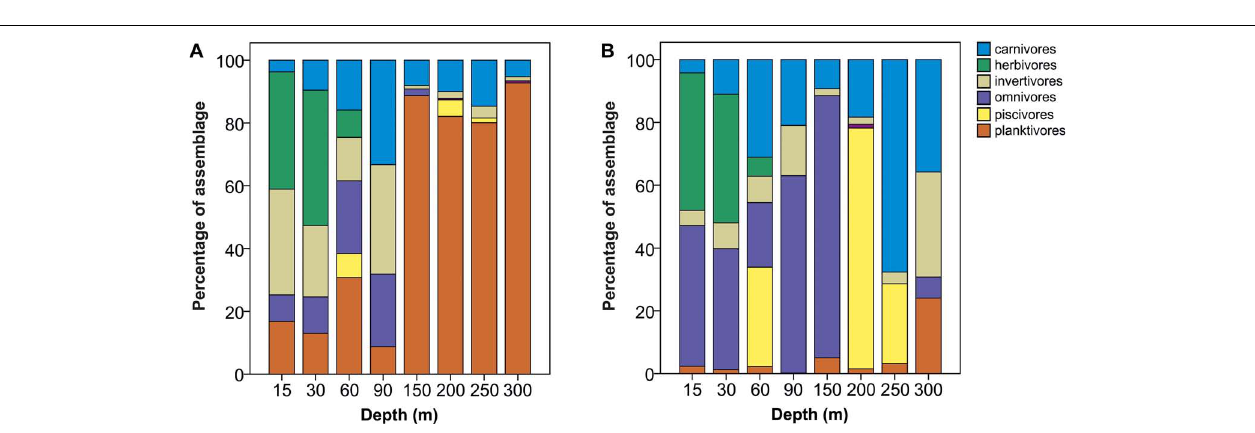
FIGURE 4 | Rank orders based on average species abundances on Plantagenet Bank and the sites from the Bermuda slope (North Northeast, Spittal, and Tiger). Lines connect the rank orders of a given species at the two localities. Species listed in regular rather than bold type were absent from the respective locality. Only transects between 60 and 300 m were considered since the summit of Plantagenet Bank lies at ∼ 45 m.